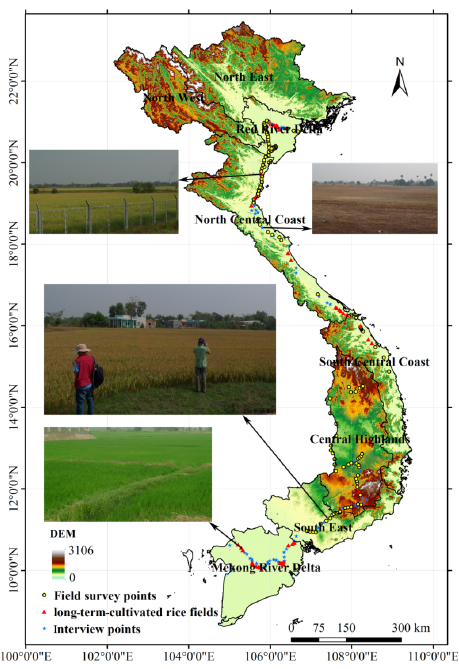
Figure 2. Field survey in Vietnam.